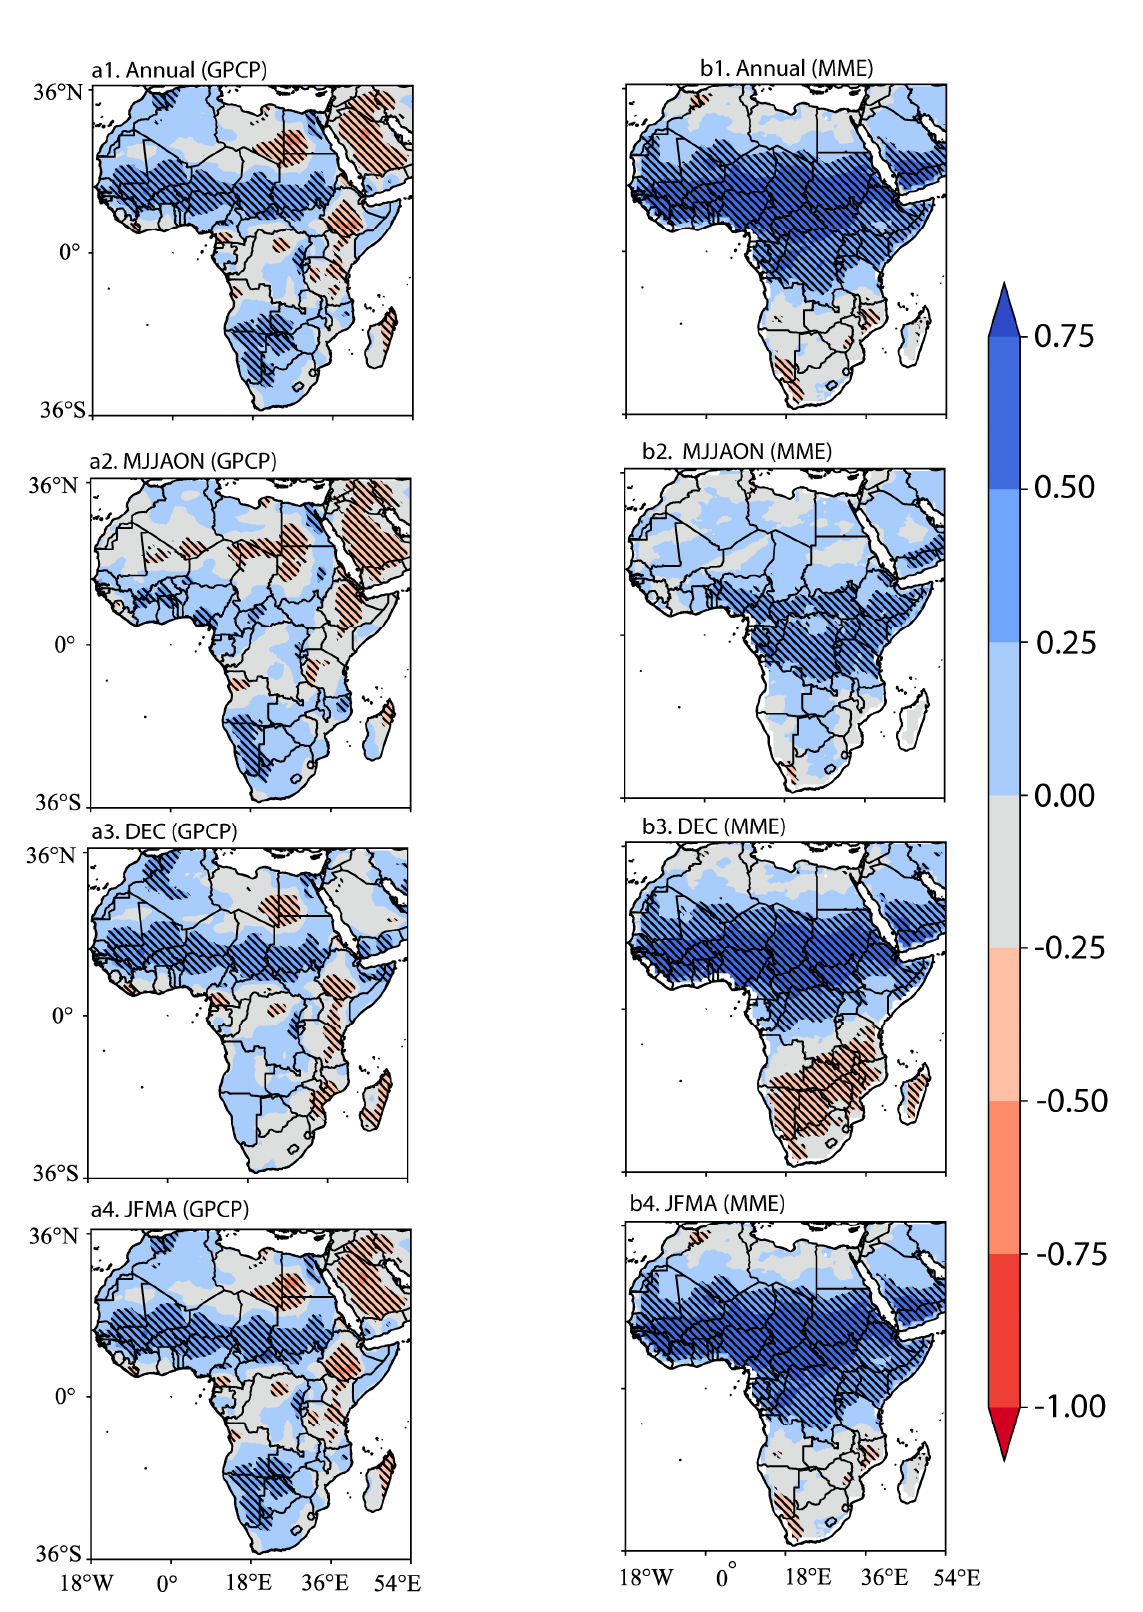
Figure 7. Linear trends of GPCP ( a1 – a4 ) (left), and MME ( b1 – b4 ) (right) at annual scale ( a1 , b1 ), JFMA ( a2 , b2 ), MJJASON ( a3 , b3 ), and December ( a4 , b4 ). The unit is mm decade − 1 . The black dots indicate that the trend passes the 0.05 significance test.